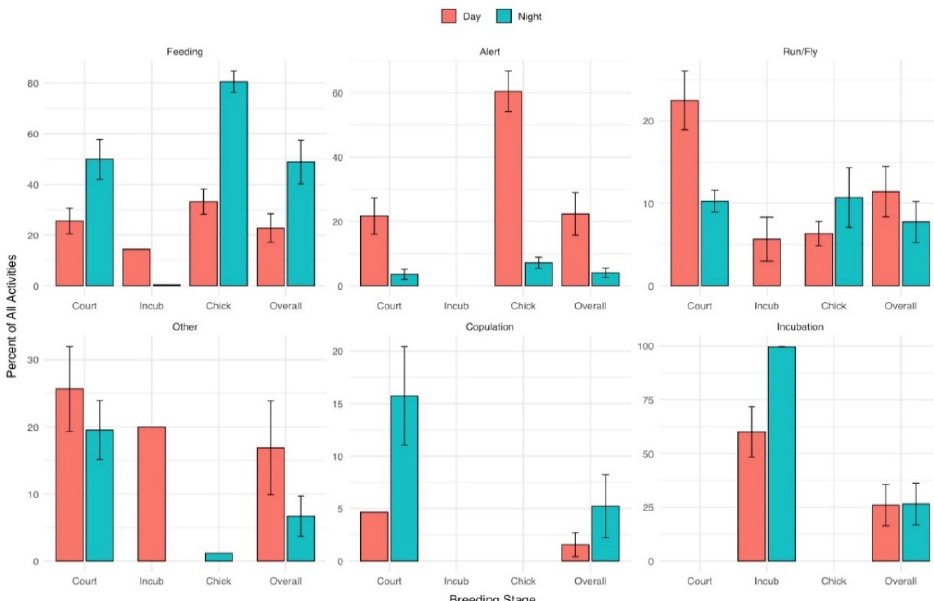
Figure 2. Cumulative time budget (percent of recorded observation ± se) for behaviors observed (feeding, alert, running or flying, other, copulation, and incubation) from 12 piping plovers throughout three stages of the 2018 breeding season along Lake Superior, Michigan, USA. We were unable to detect any significant differences in behaviors between day and night within breeding phases after applying Bonferroni corrections (Table 1). Piping plovers spent more time engaged in foraging activity at night (480.4 ± 130.4 s) than during the day (246.2 ± 105.5; p = 0.023), made similar numbers of pecks to substrate between day and night (174.8 ± 89.1 and 187.8 ± 96.6, p = 0.877), and devoted a higher percent of time to feeding at night (Figure 3), indicating that foraging efficiency may have been decreased at night. Again, we were unable to detect differences within breeding phases after application of the Bonferroni correction (Table 1). Distance the plovers were found from nests was greater during the day (206.78 m ± 61.72 m) than at night (30.37 m ± 4.29 m) (Permutation test, S = − 3.21, p = 0.011) (Figure 4), low samples sizes within breeding phases did not allow further